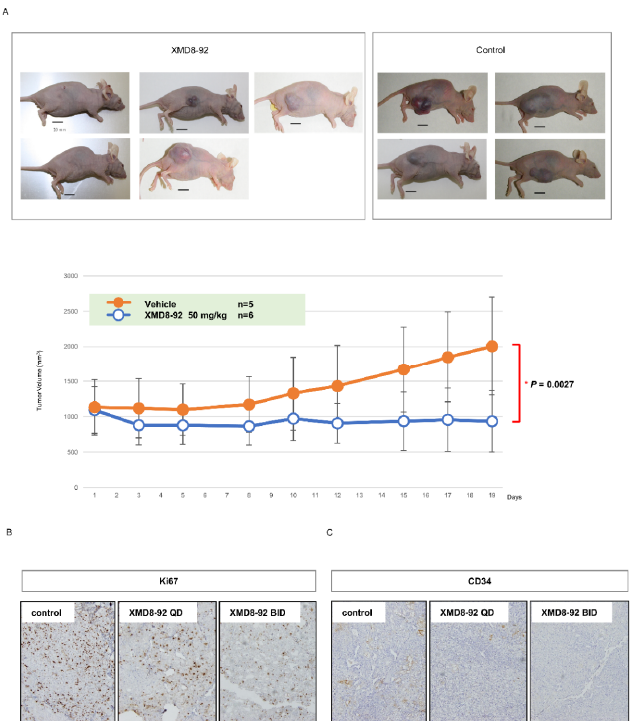
Figure 4. Subcutaneous A498 xenograft model with XMD8-92. ( A ) The mice were treated with XMD8-92 (n = 6, 50 mg/kg of body weight; fifth a week) or vehicle 20% cyclodextrin (n = 5) was administrated by I.P. injections five times weekly for 3 weeks. Data shown are mean ± SEM. The p value was determined by one-way ANOVA. ( B , C ) Mice were treated with XMD8-92 at a dose of 50 mg/kg once daily (QD), twice daily (BID), or with carrier solution intraperitoneally. Ki67 (B) and CD34 (C) expressions in the tumor were assessed by